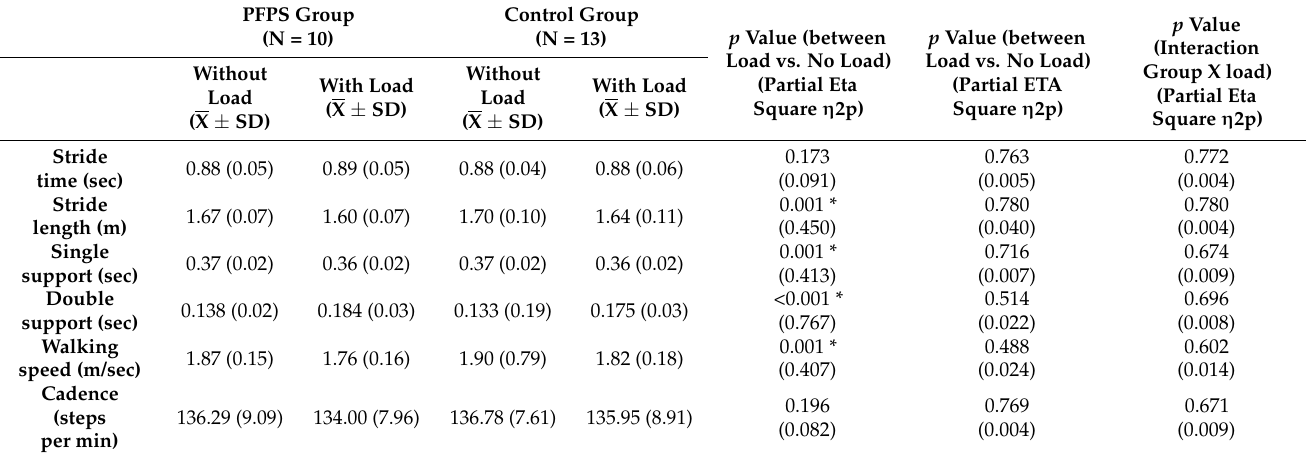
Table 5. Spatiotemporal parameters according to research groups and load